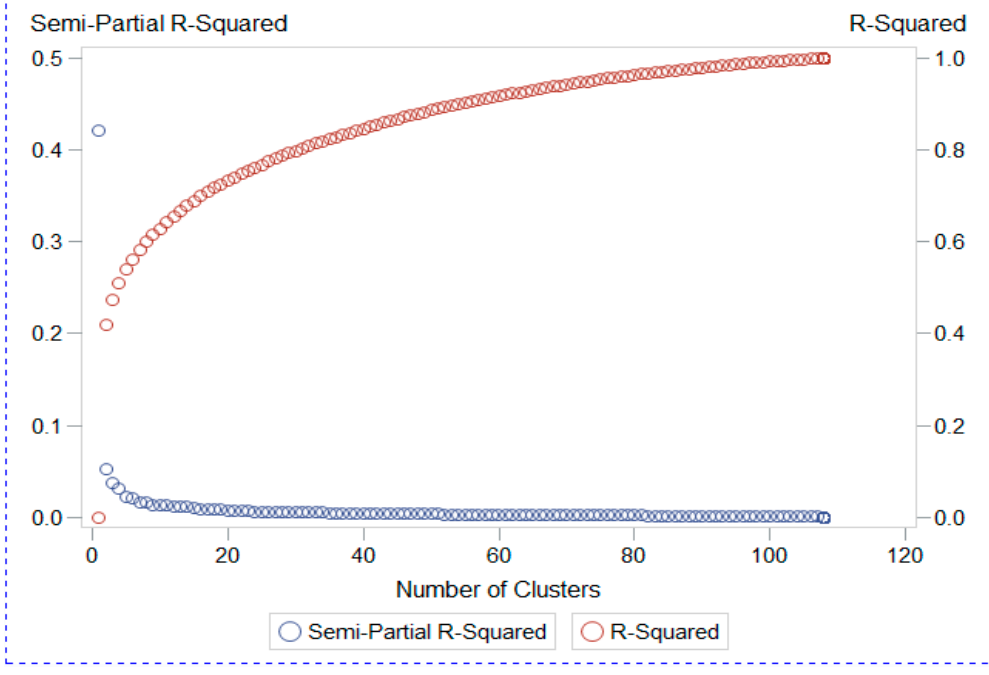
Figure 1. Scatter plot. Source: own research data.